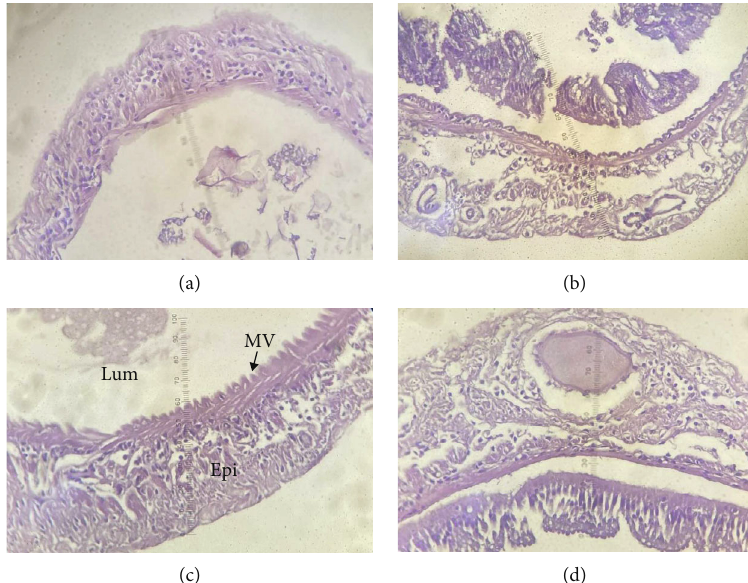
Figure 1: Light microscopic photograph of hindgut cross-section of Paci fi c white shrimp fed with pineapple waste crude extract supplementation at di ff erent levels for 80 days: (a) 0ppt, (b) 90ppt, (c) 170 ppt, and (d) 250ppt (H&E, × 10). Epi = intestinal epithelium; Lum = intestinal lumen; MV = microvilli.